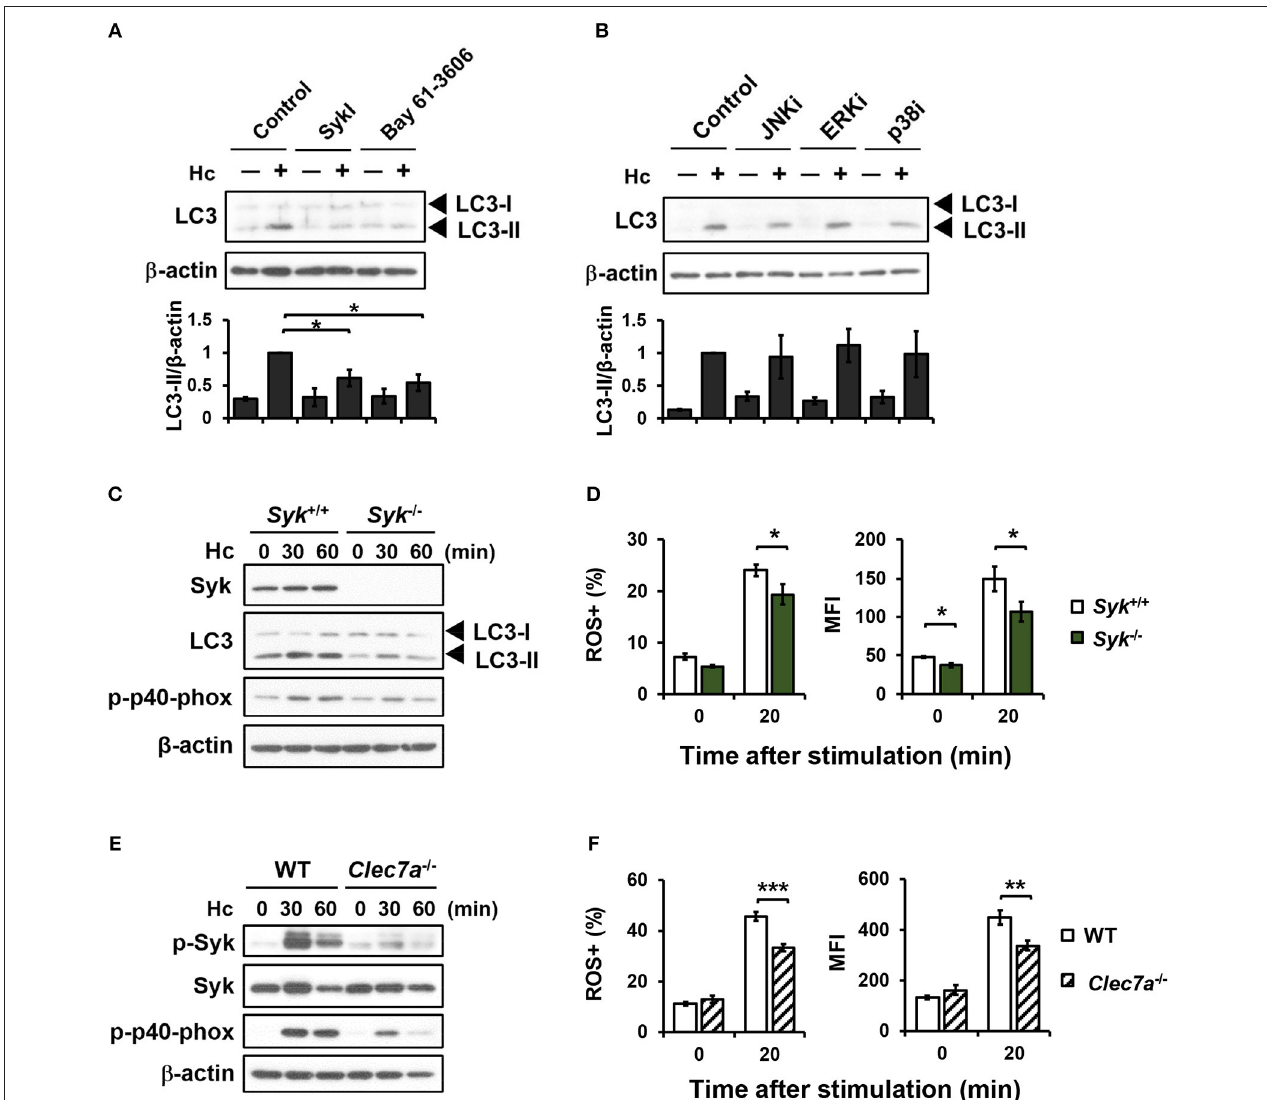
FIGURE 4 | Syk acts downstream of Dectin-1 and affects LC3-II formation by regulating ROS production. (A,B) Macrophages from WT mice were treated with Syk inhibitors (SyKI, 10 µ M; Bay 61-3606; 3 µ M) (A) and MAPK inhibitors [SP600125 (JNKi, 20 µ M); U0126 (ERKi, 20 µ M); SB203580 (p38i, 20 µ M)] (B) for 45min prior to stimulation with H. capsulatum (MOI = 5) for 1h. After stimulation, cell lysates were collected and assessed by Western blotting. Data shown in the lower panel are relative intensity of LC3-II normalized against the corresponding β -actin ( n = 3). (C,E) FLDMs from Syk + / + (WT) and Syk − / − embryos (C) or macrophages from WT and Clec7a − / − mice (E) were stimulated with or without (0min) H. capsulatum (MOI = 5) for 30 and 60min. After stimulation, cell lysates were collected and assessed by Western blotting for the expression of indicated proteins. (D,F) FLDMs from Syk + / + and Syk − / − embryos (D) or macrophages from WT and Clec7a − / − mice (F) were preloaded with CM-H 2 DCFDA for 30min prior to stimulation with or without (0min) H. capsulatum (MOI = 10) for 20min. Flow cytometry was performed to assess global ROS production. Data shown are the percentages of ROS + cells (left panel) and the mean fluorescence intensity (MFI) (right panel) of total live cells. [ n = 3–4 (D) and n = 6 (F) ]. Bars represent the mean ± SEM. * p ≤ 0.05, ** p ≤ 0.01, *** p ≤ 0.001 [ANOVA with Tukey post-hoc analysis (A,B) or Bonferroni’s multiple comparisons post-hoc test (D,F)